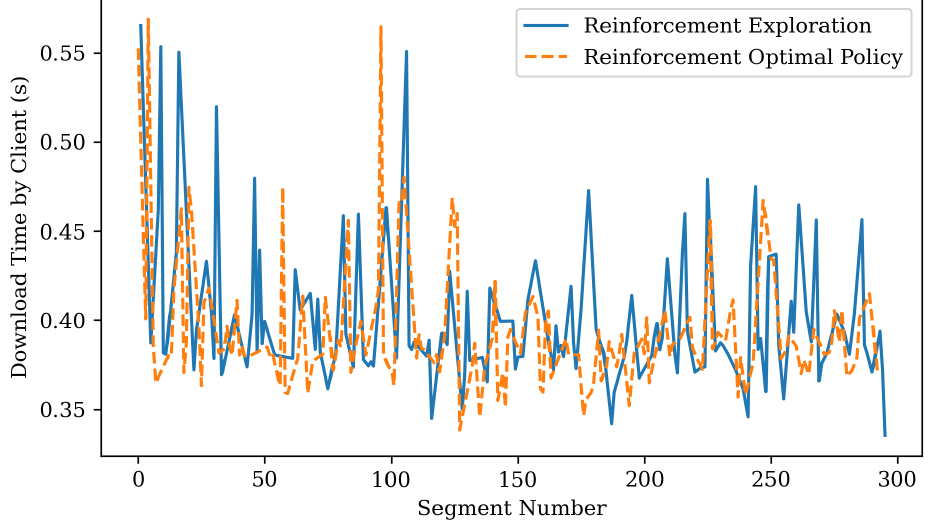
Figure 8. Changes in download time according to policy.